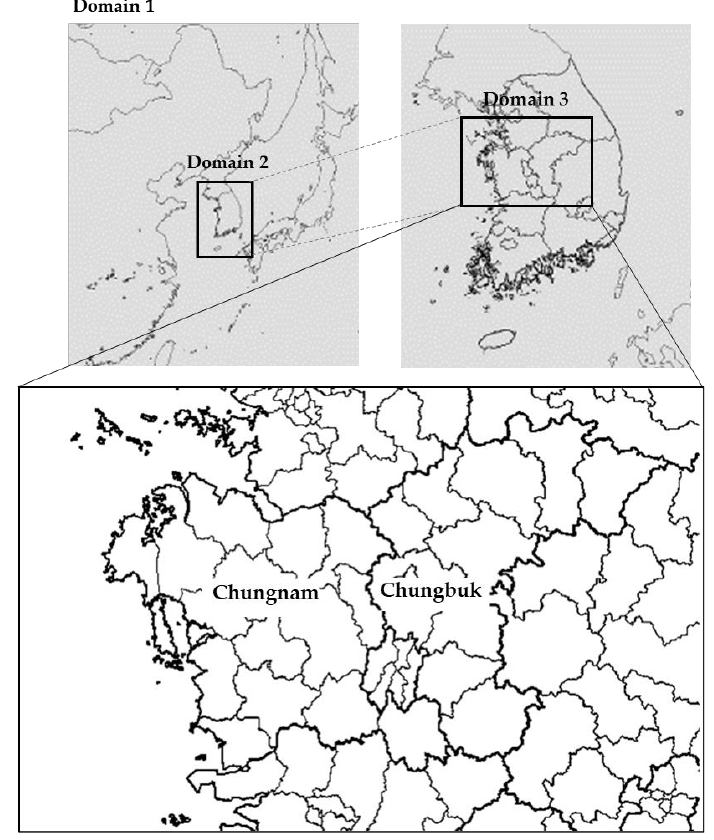
Figure 5. Simulation domain for WRF and CMAQ .